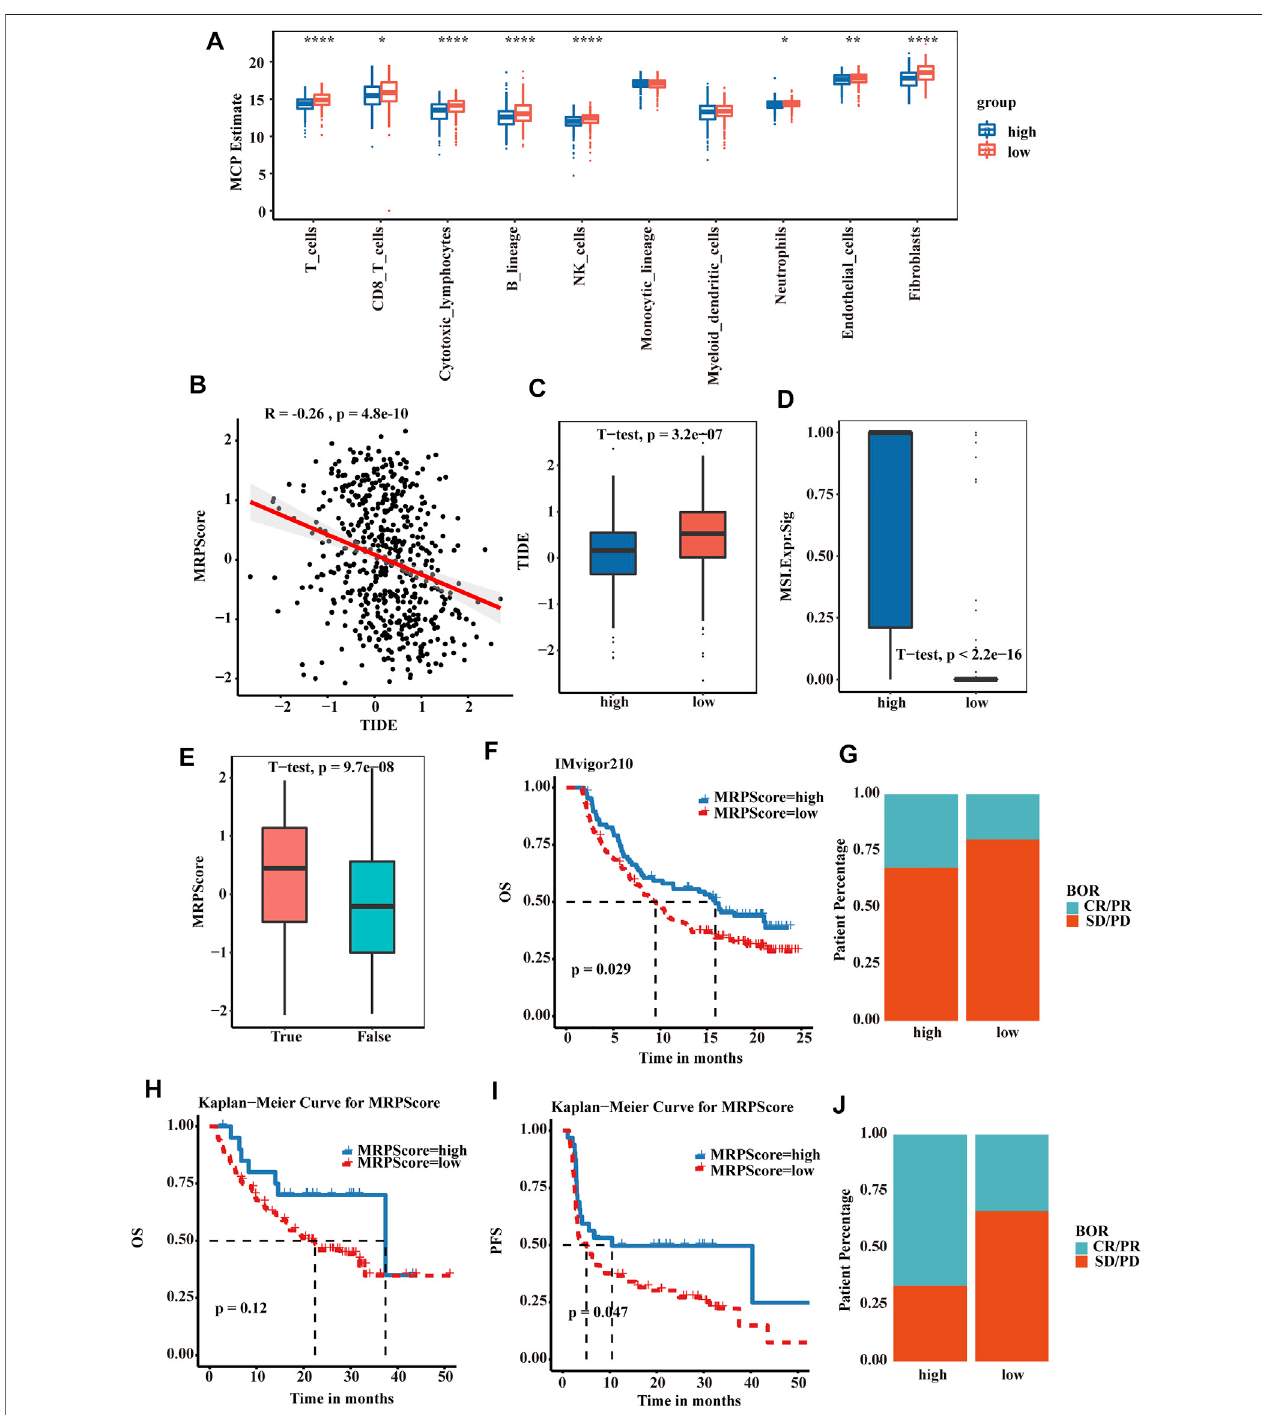
FIGURE 6 | MRPScore as an indicator for predicting the response to immunotherapy. (A) Boxplot of the abundance of immune and stromal cell populations distinguished by the high- and low-MRPScore groups. (B) Scatter plots showing the signi fi cant negative correlations between the MRPScore and TIDE score in the TCGA-KIRCcohort. (C) Boxplotrepresentingsigni fi cantlyhigherMRPScoresinthelow-MRPScoregroup. (D) Boxplotrepresentingasigni fi cantlyhigherMSIexpression signature in the high-MRPScore group. (E) Boxplot showing signi fi cantly higher MRPScores for responders in the TCGA-KIRC dataset. (F) Survival analyses for high- and low-MRPScore patient groups in the anti-PD-L1 immunotherapy cohort using Kaplan – Meier curves (IMvigor210 cohort). (G) The proportion of patients who responded to PD-L1 blockade immunotherapy in the high- or low-MRPScore groups (IMvigor210 cohort). SD, stable disease; PD, progressive disease; CR, complete response; PR, partial response. (H,I) Kaplan-Meier curve representing OS (H) and PFS (I) for the high-MRPScore and low-MRPScore groups in the melanoma cohort. (J) The proportion of patients who responded to immune checkpoint blockade therapy in the high-MRPScore and low-MRPScore groups in the melanoma cohort. p values were determined by a student ’ s t